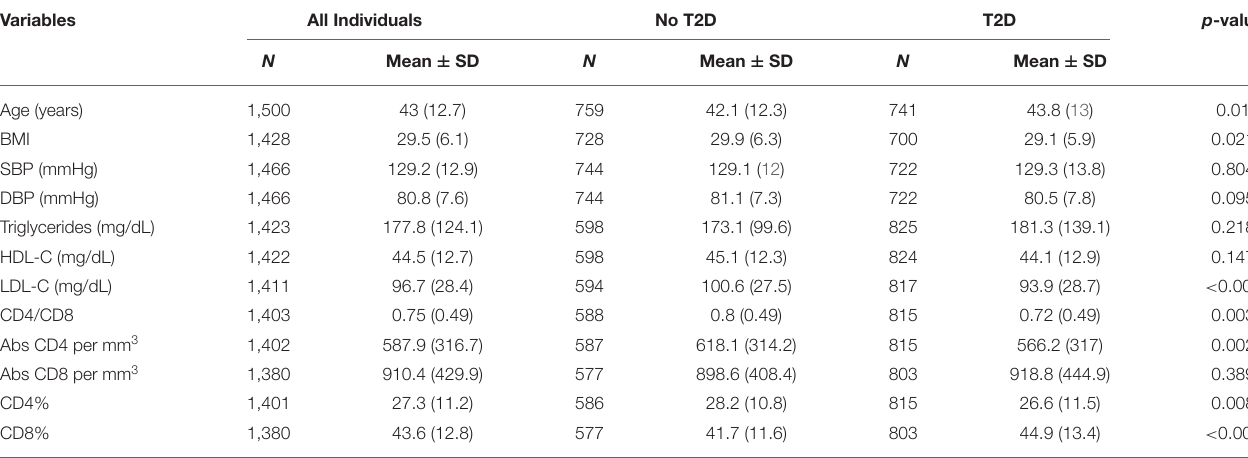
TABLE 3 | Descriptive statistics of the VACC individuals stratified by T2D status ¶